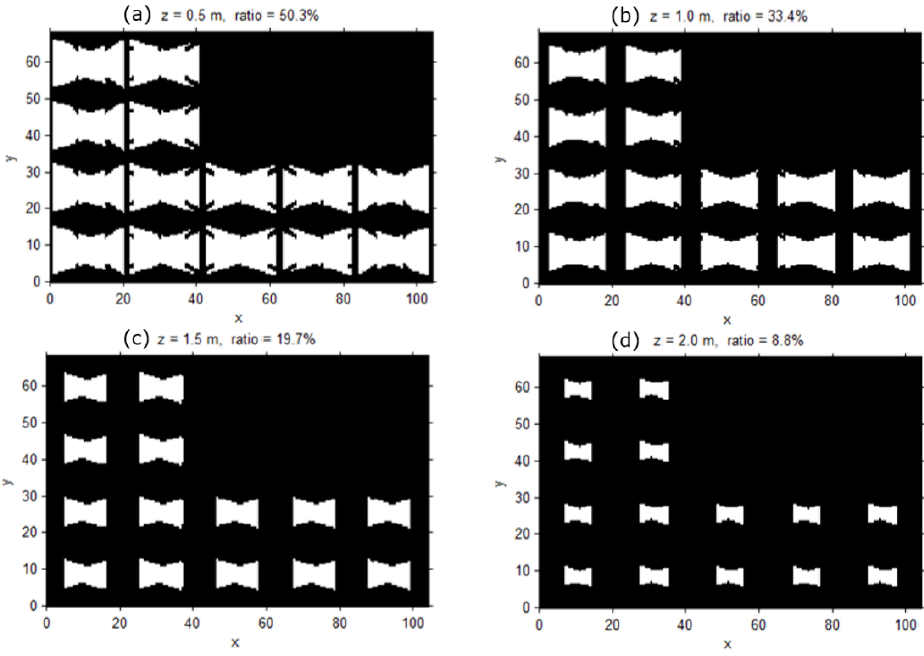
Figure 8. Surveillance coverage index with a threshold of 1 px/cm according to the elevation when objects have an upper-vertical orientation; ( a ) the index at the elevation of 0.5 m; ( b ) the index at the elevation of 1 m; ( c ) the index at the elevation of 1.5 m; ( d ) the index at the elevation of 2